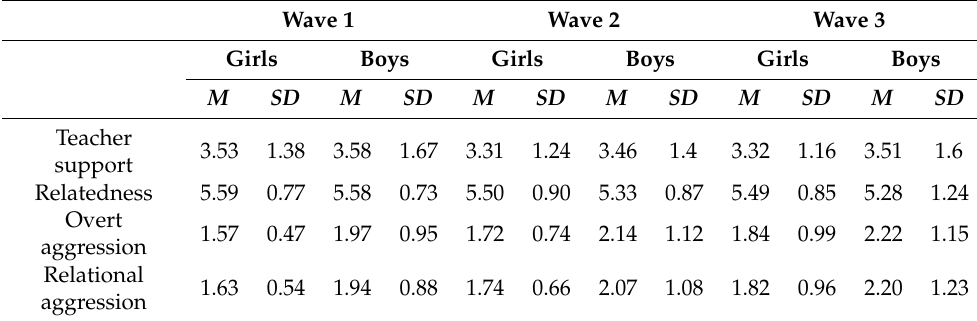
Table 2. Means and standard deviations at the three measurement waves for girls ( N = 342) and boys ( N = 312). Wave 1 Wave 2 Wave